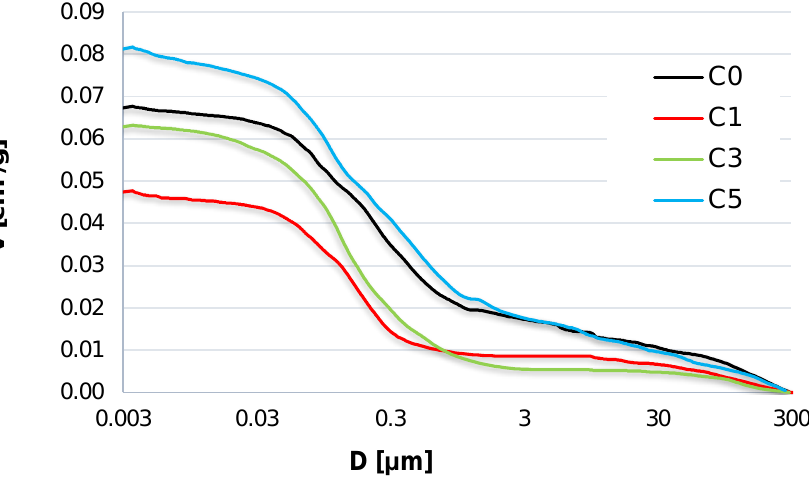
Figure 11. Cumulative porosity graphs of the tested concrete specimens (MIP).